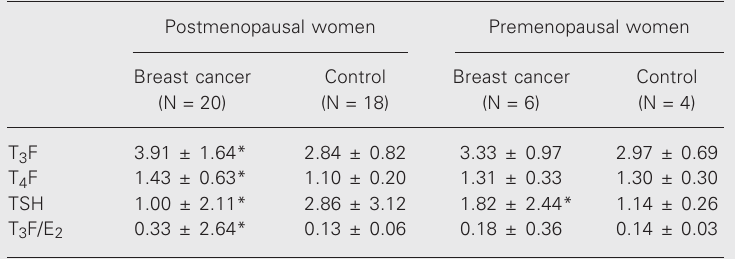
Table 1. Serum thyroid hormone levels in breast cancer patients and control individu- als classified by menopausal status.